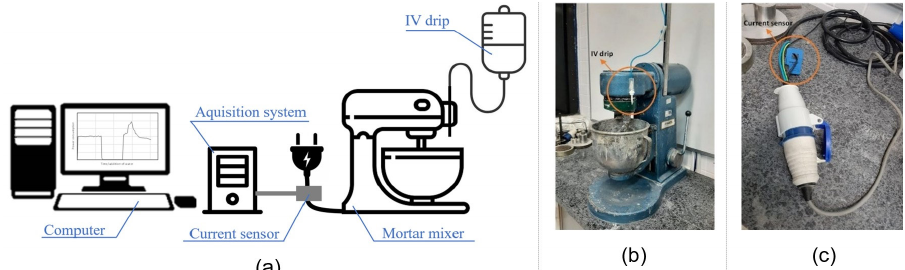
Figure 5. Mixing energy test: (a) set up schematic illustration (b) IV drip flow regulator and (c) current